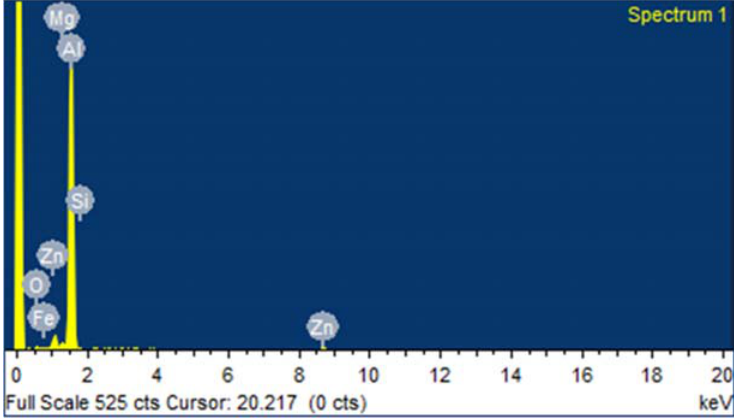
Figure 10: EDS spectrum of wornout surface composite sample (Al + 8 % SiC + 8 % Al 2 O 3